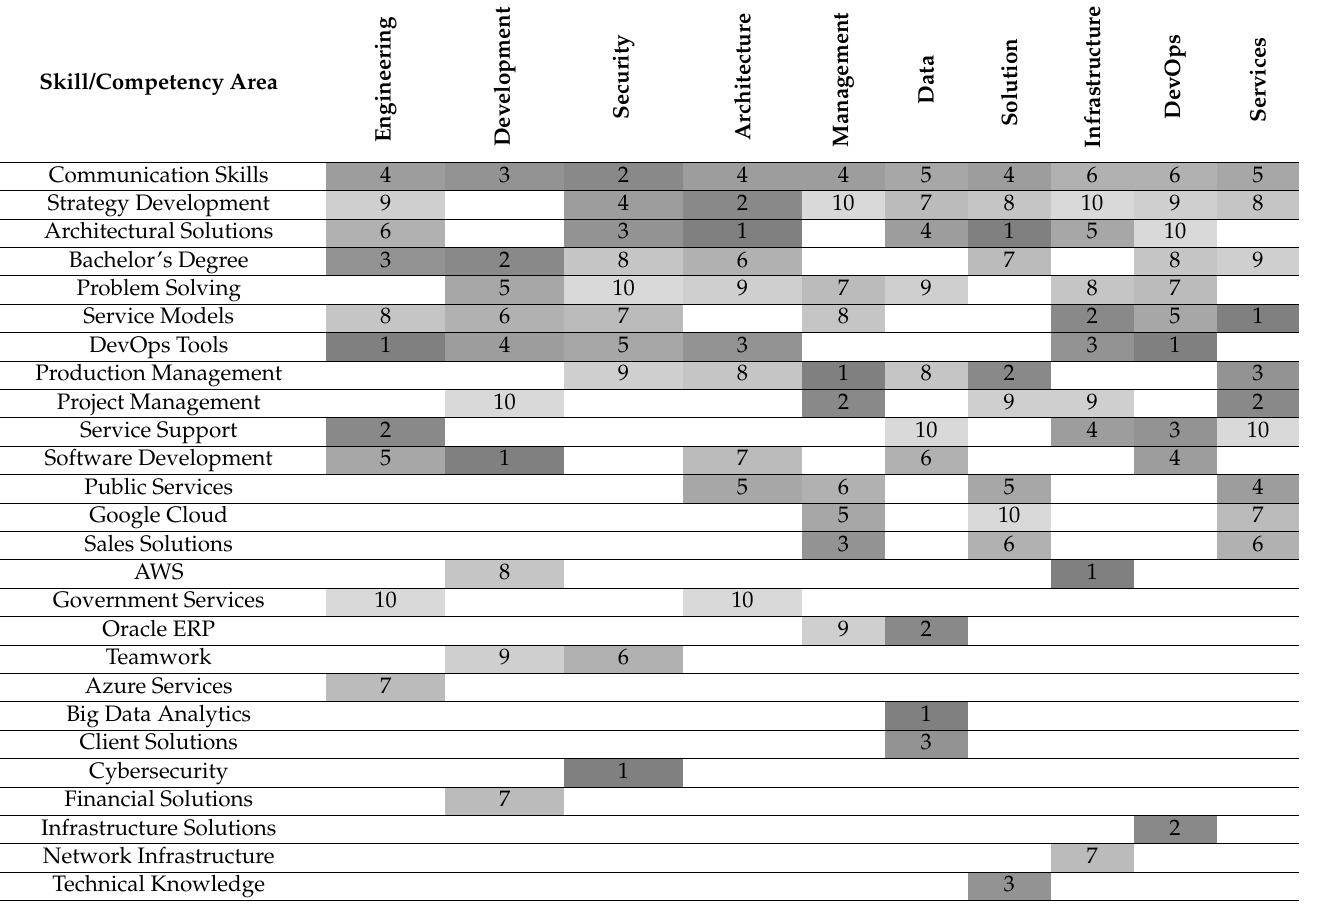
Table 4. Ranking of the top 10 skills for each of the top 10 competency